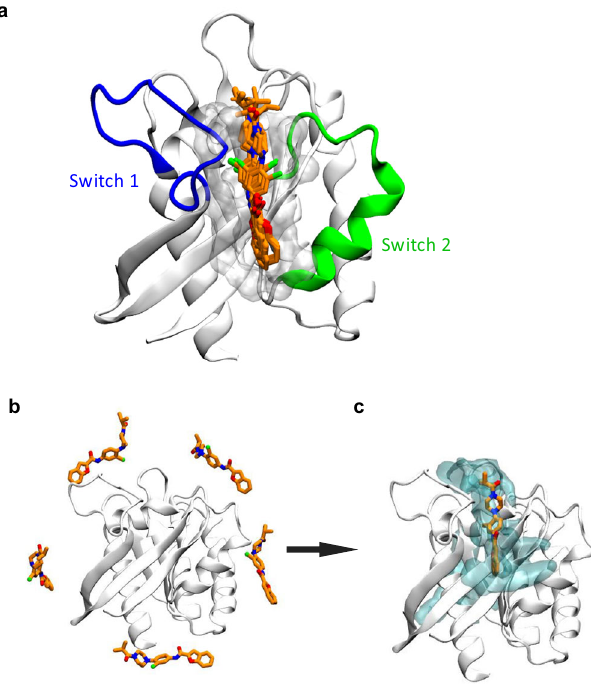
Fig. 5 In silico studies reveal interactions between Rasar fi n and Ras. a Shown are the 8 best-scored docking poses of Rasar fi n in licorice representation (orange) bound in the groove between switch I and switch II on Ras (protein in white cartoon, binding groove surface in silver). b – c Unbiased simulations of Rasar fi n association to Ras. b Shown is the initial placement of Rasar fi n molecules (orange licorice) around Ras to study the spontaneous association of the ligand to Ras (white depiction). c Spontaneous association of Rasar fi n to Ras approximated using a volumetric map of average ligand occupancy at 0.15 threshold (cyan transparent surface). The binding mode of Rasar fi n obtained through docking is overlayed for comparison (orange Superimposition of Rasar fi n onto SOS1-bound Ras revealed that